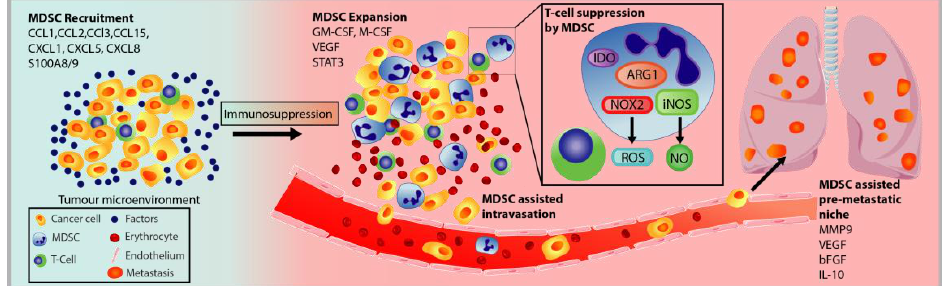
Figure 4. Schematic of MDSC recruitment and role in cancer progression and metastatic spread. MDSC are recruited to the tumour site by the same factors that mobilise neutrophils and monocytes. Within the tumour microenvironment, the MDSC population expands and exerts their immunosuppressive functions to induce T-cell and NK cell anergy through different mechanisms, such as through the enzymes IDO, ARG1, iNOS, and NOX2. MDSC can also assist in cancer cell dissemination through the promotion of angiogenesis, EMT and MET transition, and secretion of tumourigenic factors.